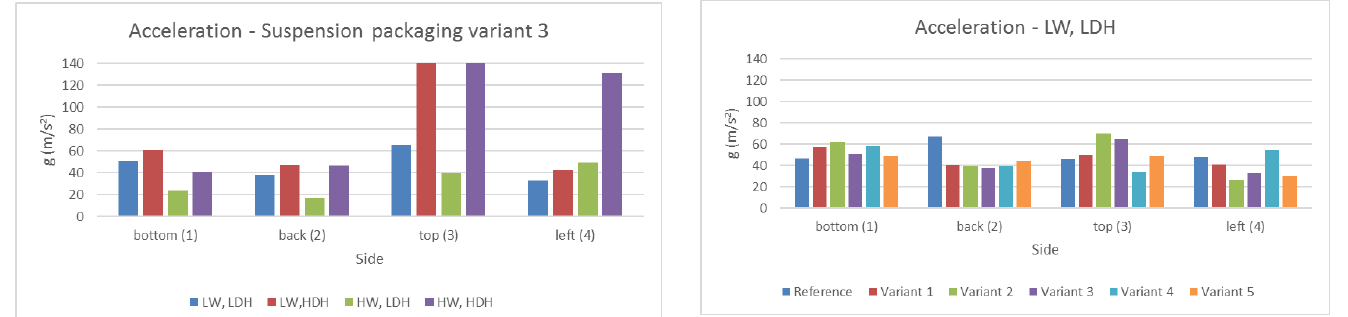
Figure 12: Acceleration - LW,